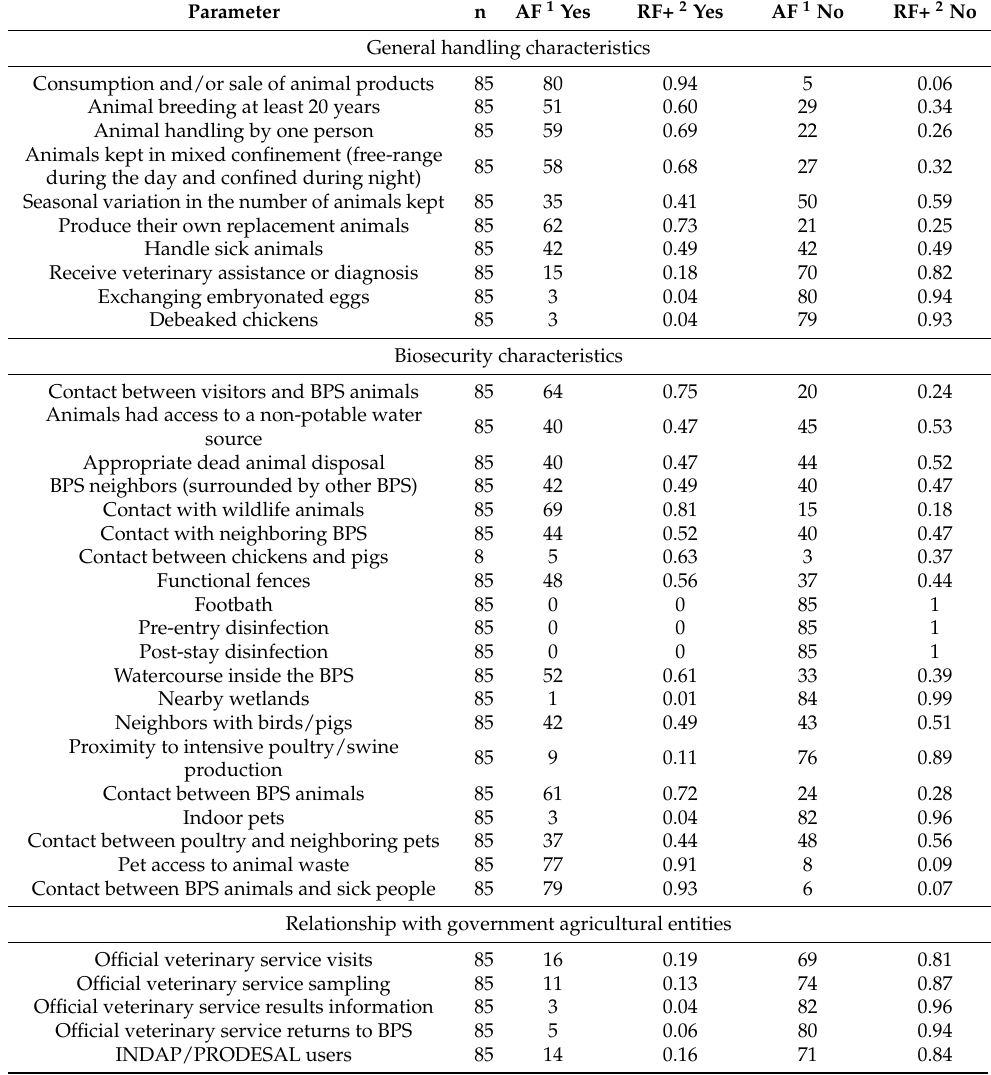
Table 3. Handling, health and biosecurity characterization of BPS from Metropolitana region.